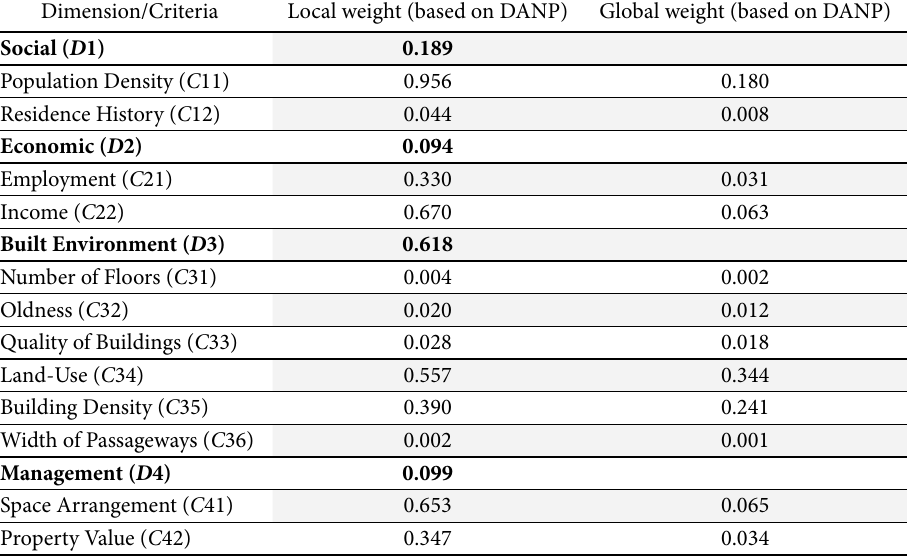
Table 10. Influential weights and relative importance of